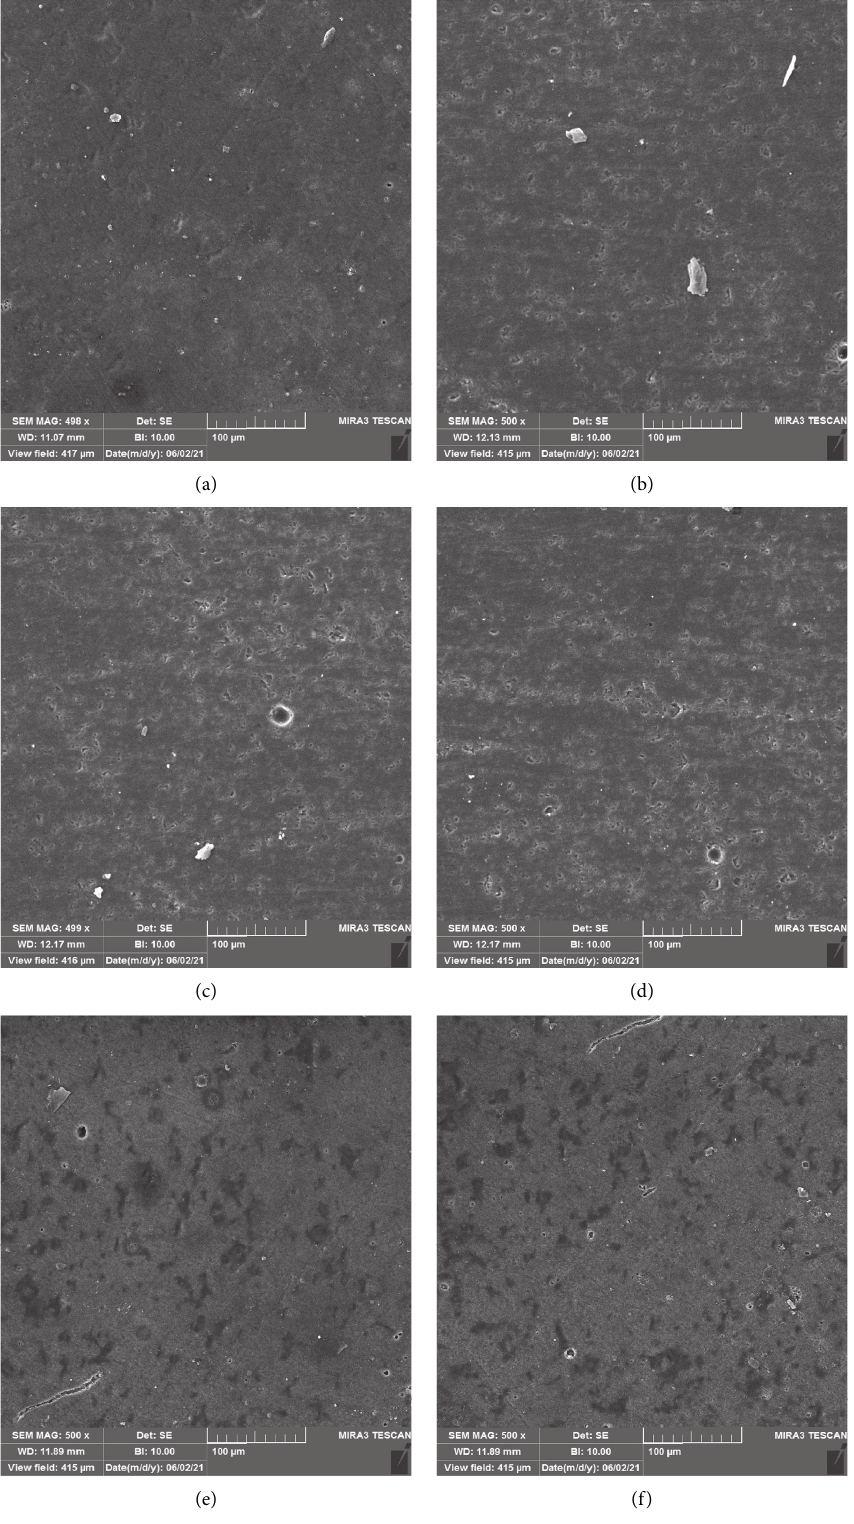
Figure 1: Scanning electron microscope photomicrographs of IPS e.max CAD (a) before immersion and after immersion in (b) saliva, (c) acetic acid, (d) gastric acid, (e) fluoride and acetic acid, and (f) fluoride and gastric acid 4 (500X